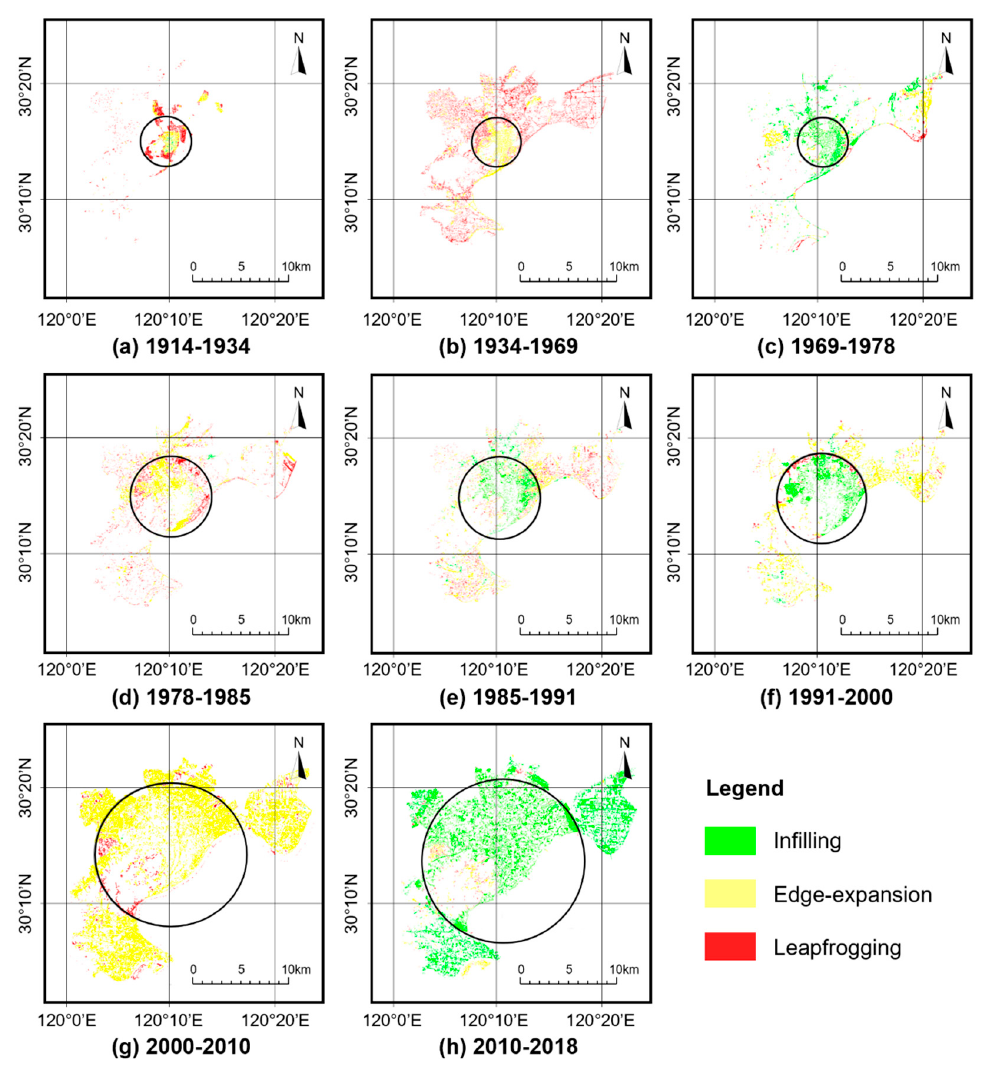
Figure 6. The spatial distribution of urban growth types (infilling, edge-expansion, and leapfrogging) in Hangzhou from 1914 to 2018. The black circles divide the entire urban area into inner and outer zones according to the area–radius relationship shown in Table 4.